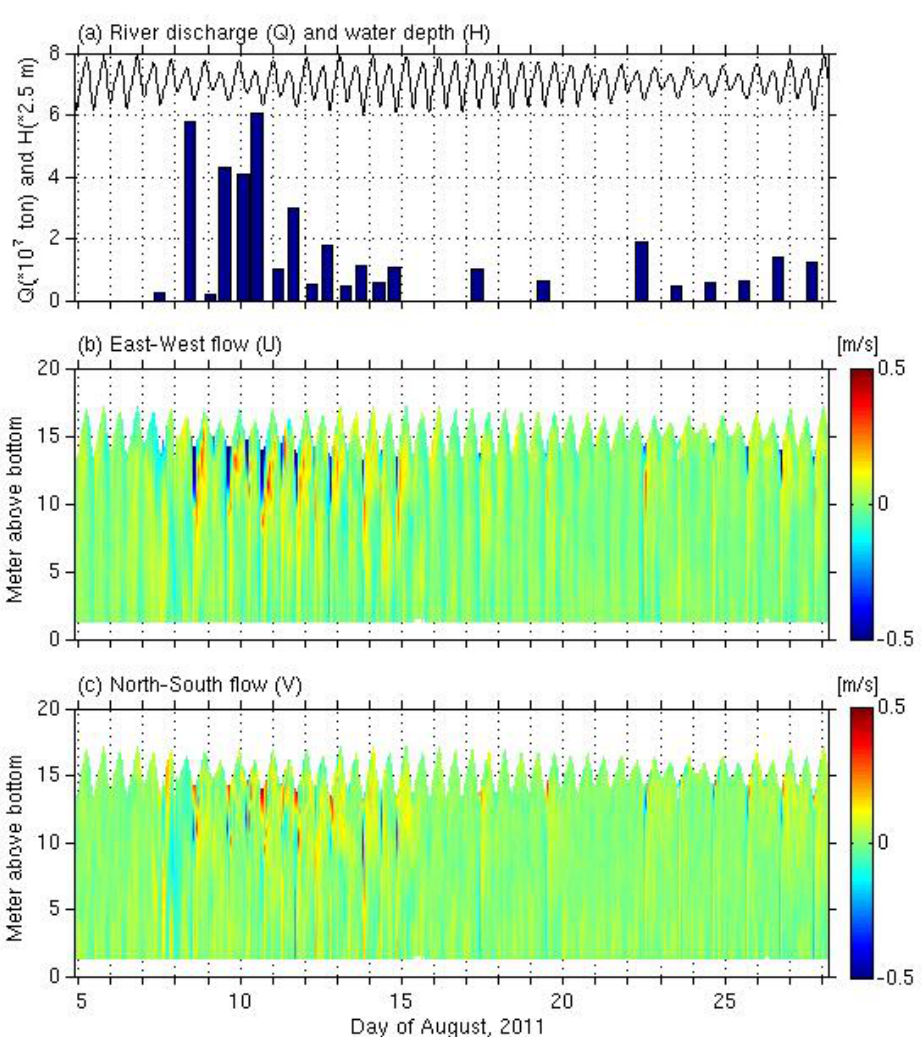
Figure 2. Time series of the freshwater discharge and water flow. ( a ) Freshwater discharge and water depth, ( b ) u-component of current velocity, ( c ) v-component of current velocity. In (b) and (c), negative values indicate west- and south-directed velocities, respectively.